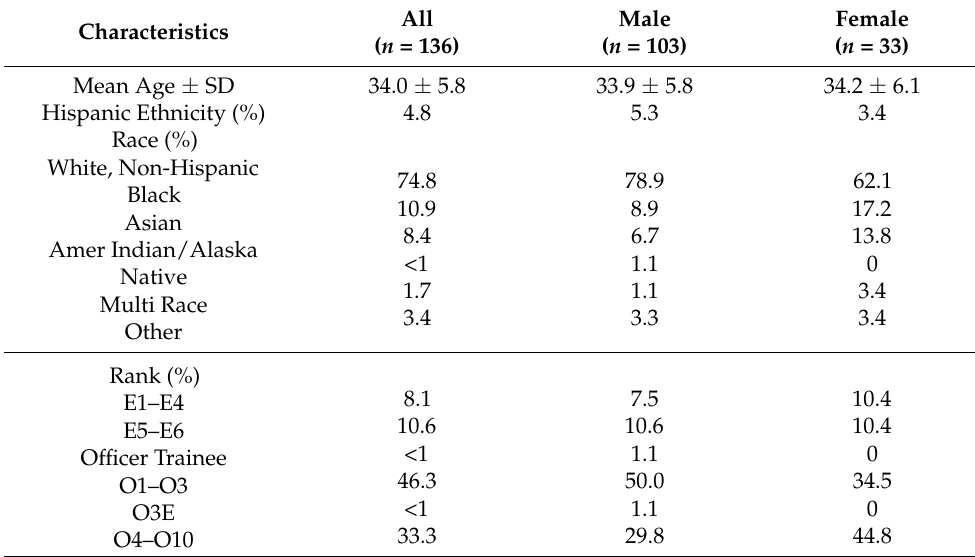
Table 1. Sample characteristics by